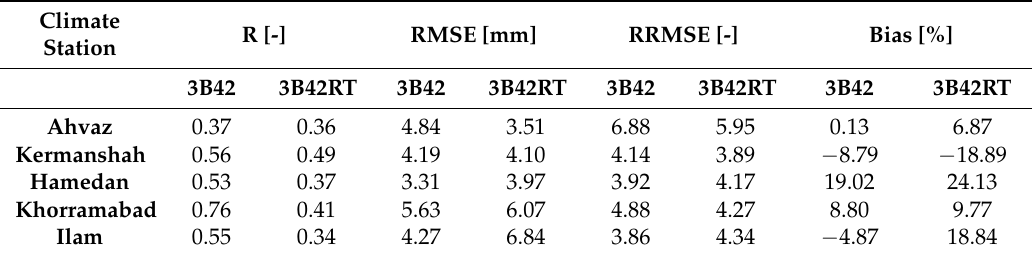
Table 6. Statistical performances of the bias- corrected TRMM (TMPA3B42, 3B42RT) at the different